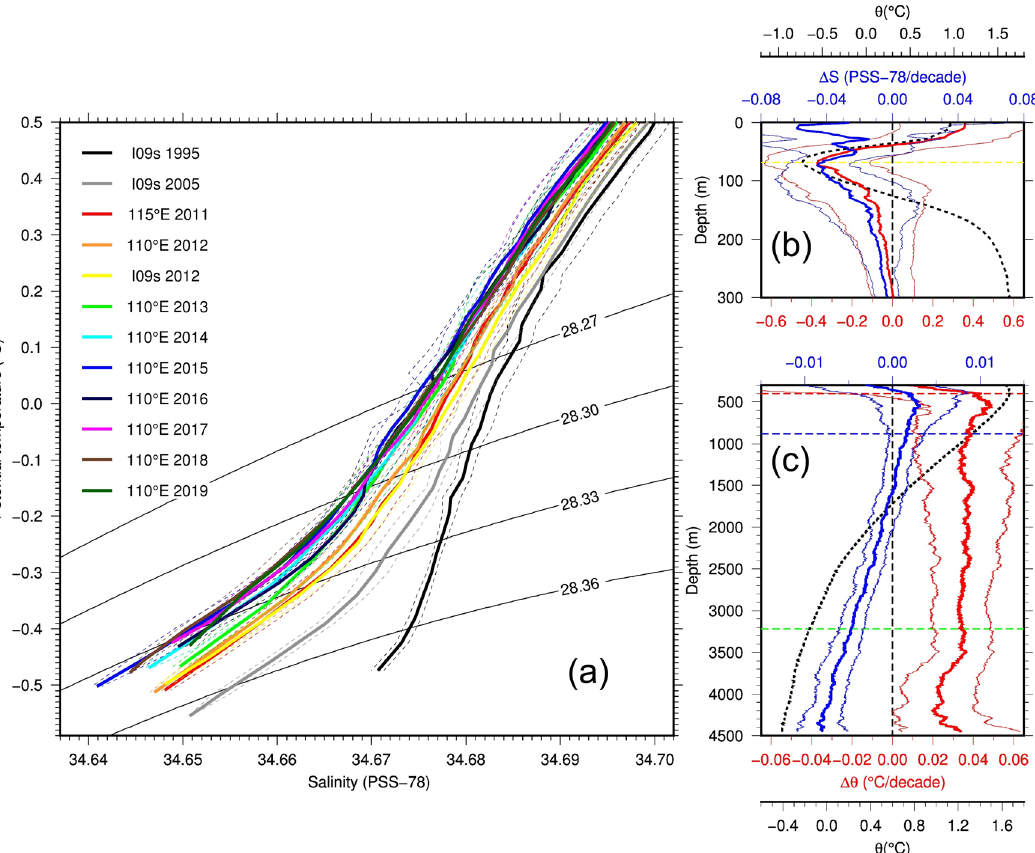
Fig. 2 Multi-decadal variability in potential temperature and salinity in the core region in the Australian-Antarctic Basin (core AAB). a θ - S changes in the core AAB. θ -S curves were averaged on isopycnal surfaces for each section, and broken lines indicate standard deviations. θ -S curves are coloured according to the observation year in the same manner as the observation points in Fig. 1a. b , c are vertical pro fi les of the linear trends in potential temperature (red) and salinity (blue) in layers above and below 300 m, respectively. Thin lines indicate the 95% con fi dence interval. Note that the abscissa is substantially different. The pro fi le of the mean (spatio-temporal) potential temperature is shown by the black broken lines. The depth of the potential temperature minimum, potential temperature maximum, salinity maximum and γ n = 28.30 kg m − 3 (corresponding to the top layer of the Antarctic Bottom Water) are shown by yellow, red, blue and green broken lines,